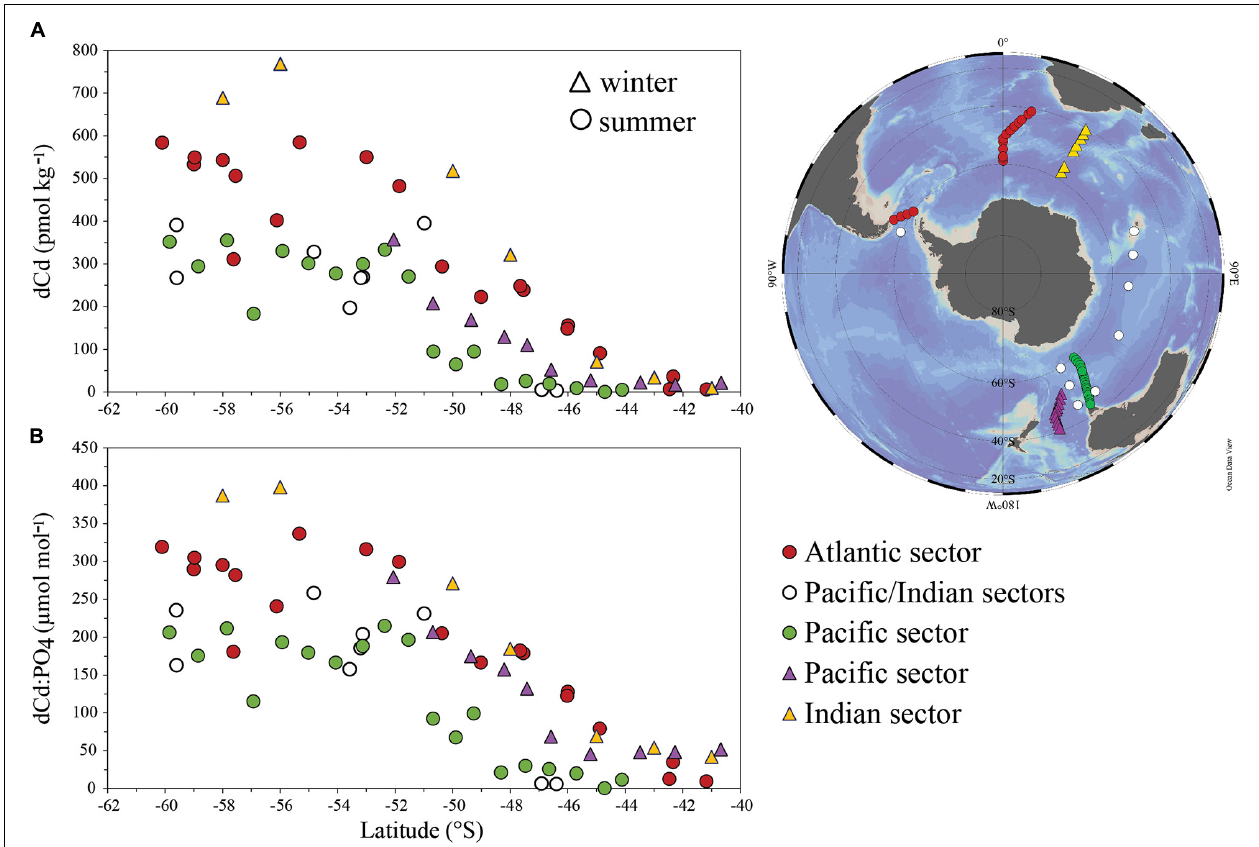
FIGURE 4 | Southern Ocean surface ( ∼ 25 m) comparisons of (A) dCd against latitude and (B) dCd:PO 4 spot ratios against latitude from the various sectors of the Southern Ocean and during both winter and summer seasons. References as follows: Atlantic sector (Boye et al., 2012; Baars et al., 2014); Pacific/Indian sectors (Janssen et al., 2020); Pacific sector (summer: Butler et al., 2013; winter: Ellwood, 2008): Indian sector (This